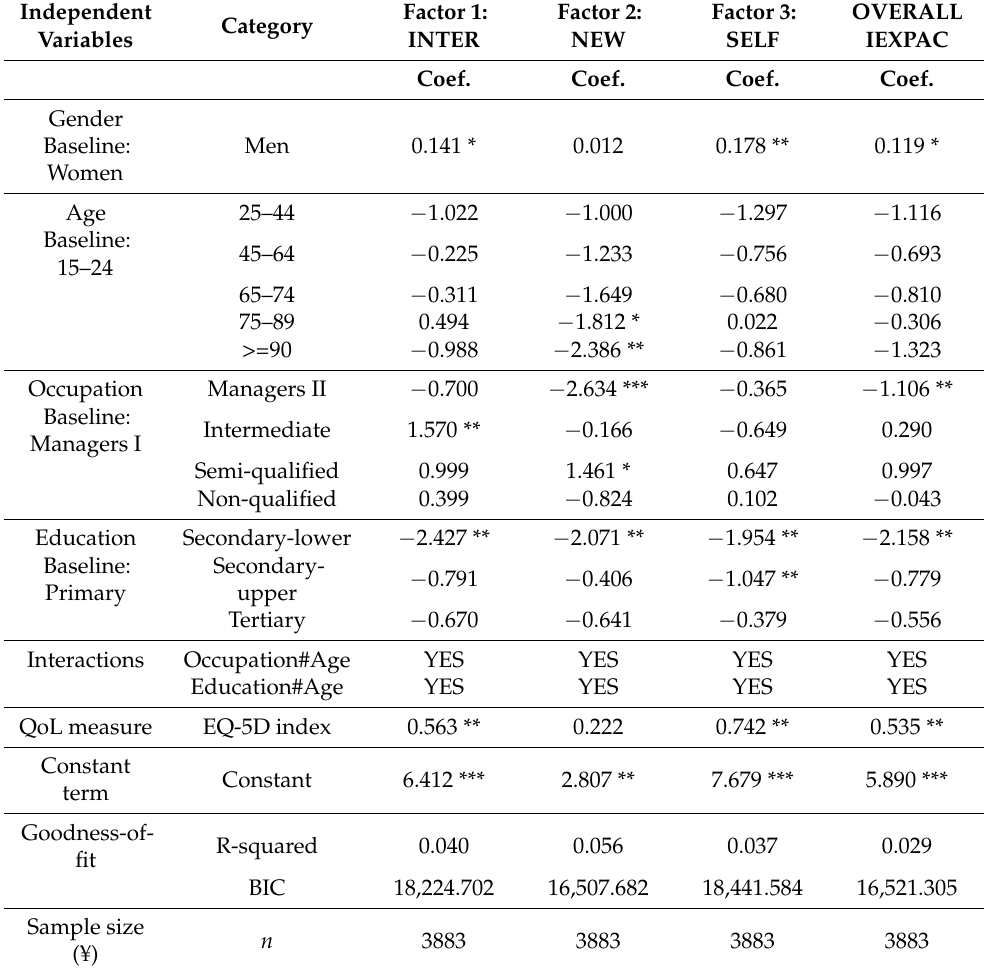
Table 6. Model 4—WLS results. Differences in health care experience among patients with self- declared chronic conditions. The effect of quality of life is represented by the